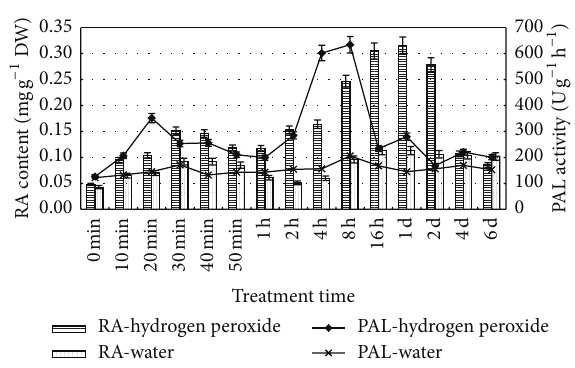
Figure 3: Exogenous hydrogen peroxide promotes PAL activity and RA production in the S . miltiorrhiza suspension cell cultures. 6-d-old cells treated with 10mM H 2 O 2 were harvested at the time as indicated, and RA contents and PAL activities were then determined. Values are means of three independent experiments. Bars represented standard